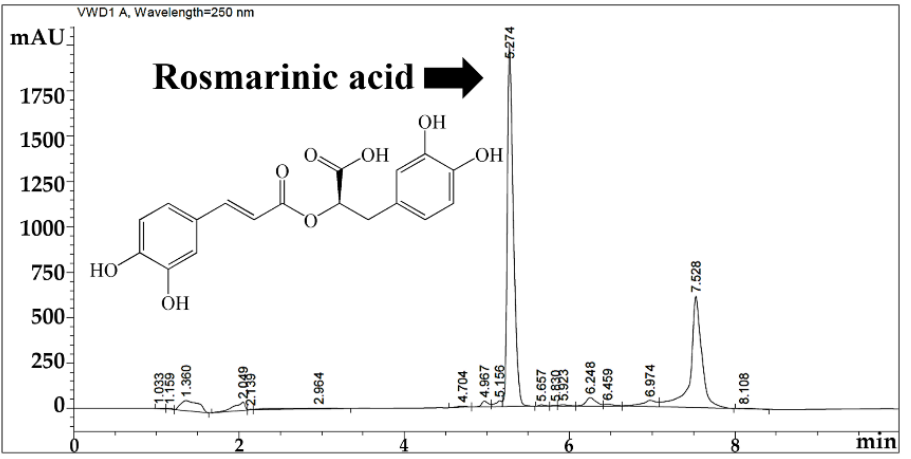
Figure 1. HPLC chromatogram of O. sanctum ethanolic extract: Rosmarinic acid (RA) was detected as a major component.